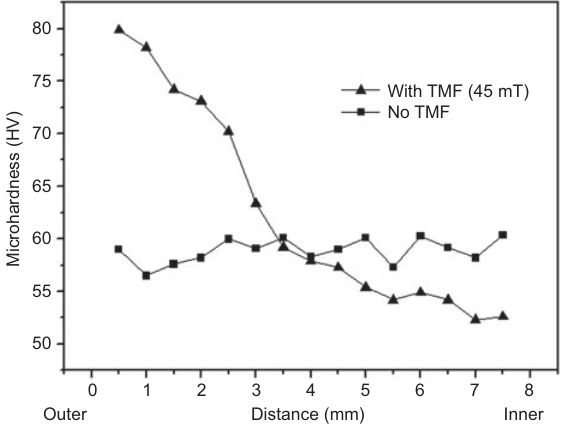
Figure 8 The microhardness distribution of the sample depending on the distance.